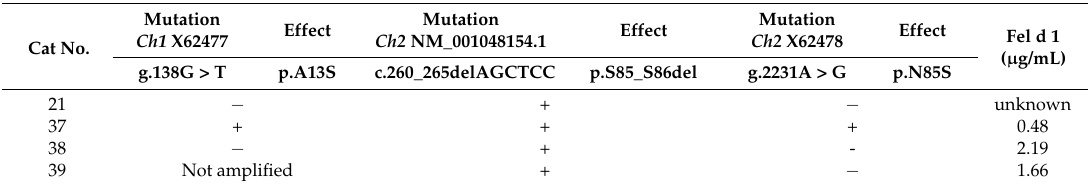
Table 1. Main mutations affecting the coding sequence of Ch1 and Ch2 genes in some Siberian cats: position on a GenBank reference sequence, effects on amino acid sequence, and Fel d 1 concentration in saliva. Minus and plus signs mean absence or presence of the mutation. Mutation Mutation Mutation Effect Effect Ch1 X62477 Ch2 NM_001048154.1 Ch2 X62478 Cat No.